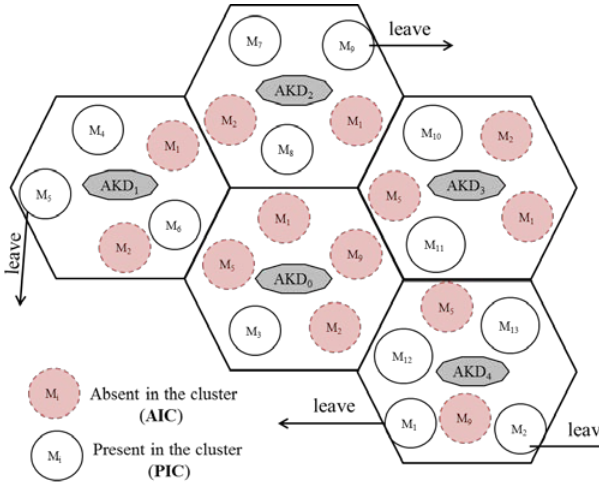
Figure 1 . High mobility scenario with multiple